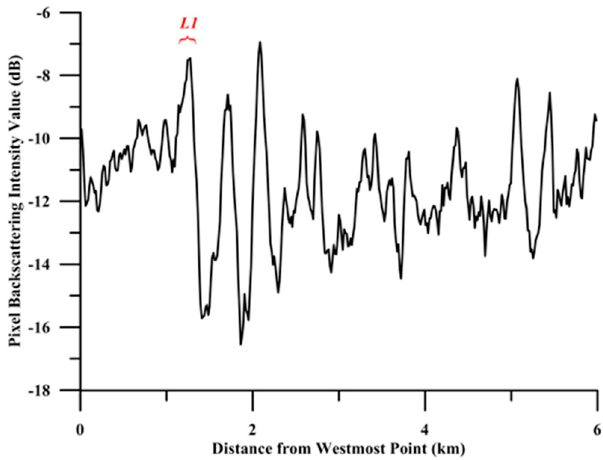
Figure 2. A portion of ( a ) the GF-3 SAR image acquired at 22:43 UTC on 10 June 2017 and ( b ) a TS-X image acquired at 22:32 UTC on 10 June 2017. The yellow arrows superimposed on the GF-3 sub-image show the ERA5 reanalysis sea surface wind vectors (hourly available at 0.25 degree grids) at 23:00 UTC on 10 June 2017.